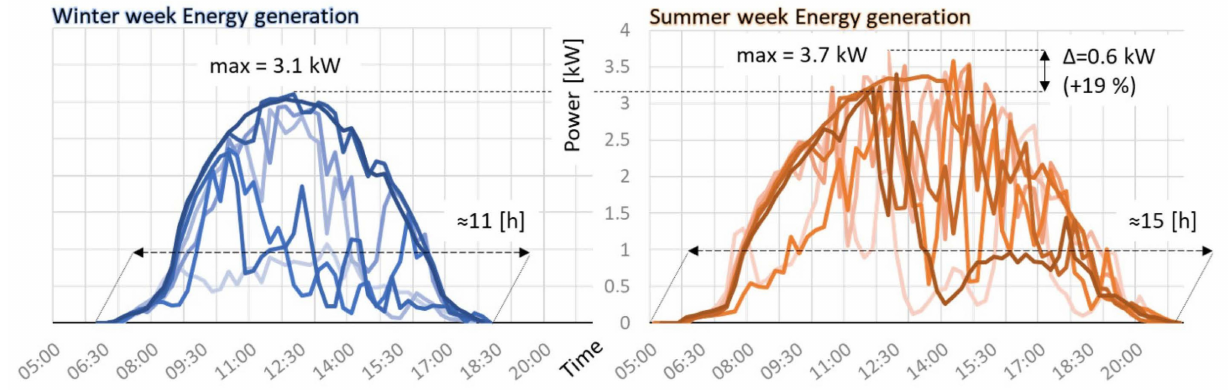
Figure 7. The data from 4.48 kWp solar energy installation located in Poznan city in Poland—energy generated during the winter and summer weeks, collected by the Sunny Tripower 5.0 data acquisition system.